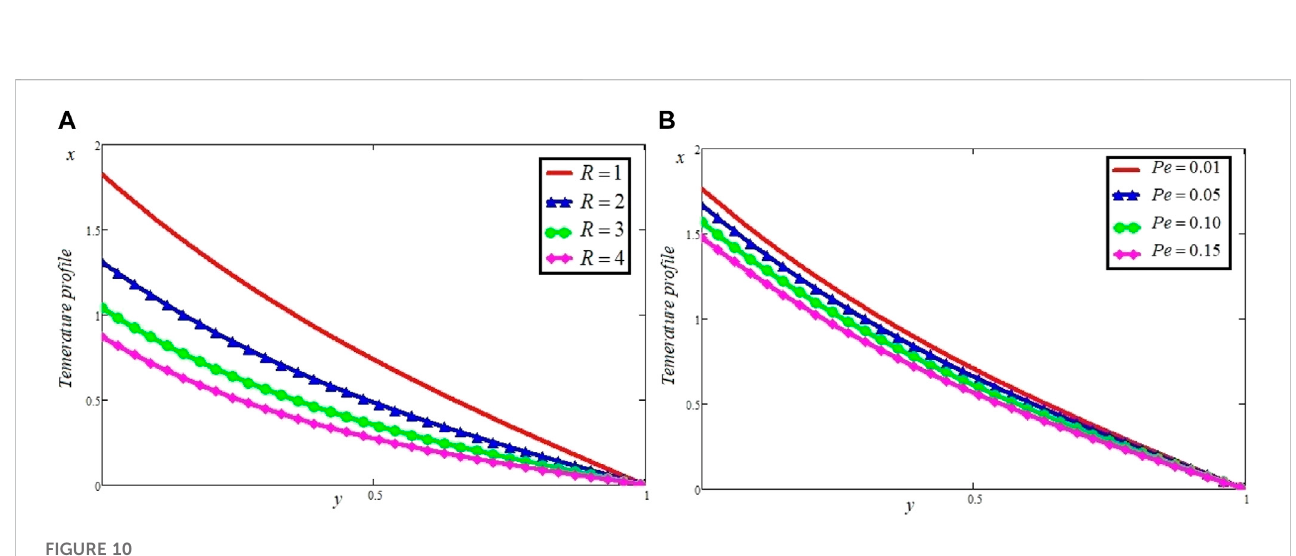
FIGURE 10 Effect of R and Pe on θ ( y , t ) . When Pe (cid:2) 2 , R (cid:2) 3 ϕ (cid:2) 2 , and γ (cid:2) 2.